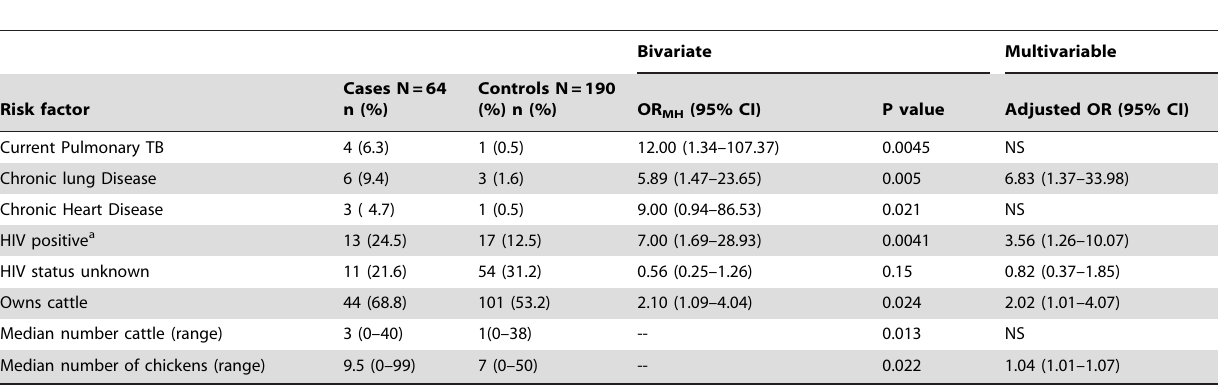
Table 3. Results of bivariate and multivariable analysis of risk factors for hospitalized influenza A and B, indicating the factors that were included in the multivariate model (p , 0.10), Bondo District, Kenya,